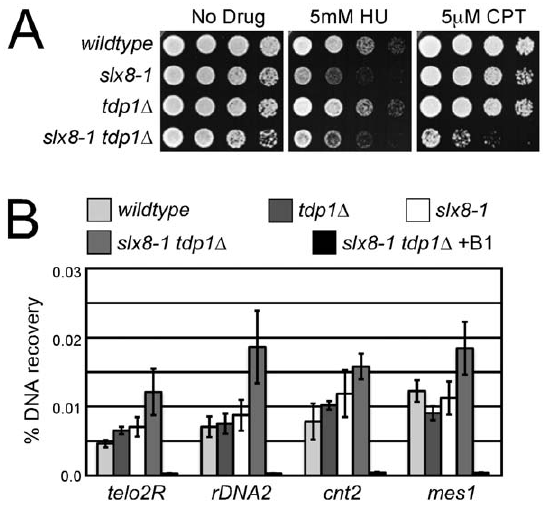
Figure 1. STUbL mutant tdp1 D cells are synergistically sensitive to CPT and have increased spontaneous Top1cc levels. (A) Serial dilutions of the indicated strains were spotted onto media with or without the indicated drugs. (B) ChIP-qPCR assays of an nmt41 - inducible Top1-FLAG in the indicated strains, at the subtelomeres of Chr 2 ( telo2R ), the centromeric inner repeats of Chr 2 ( cnt2 ), the rDNA ( rDNA2 ), and upstream of mes1 on Chr 1. The data represents the average DNA recovery compared to the input DNA samples with standard deviations from four independent experiments. ChIP-qPCR data of nmt41 -Top1-FLAG slx8-1 tdp1 D cells grown in repressing media ( + B1) acts as a negative control. Cells were grown at 25 u C.